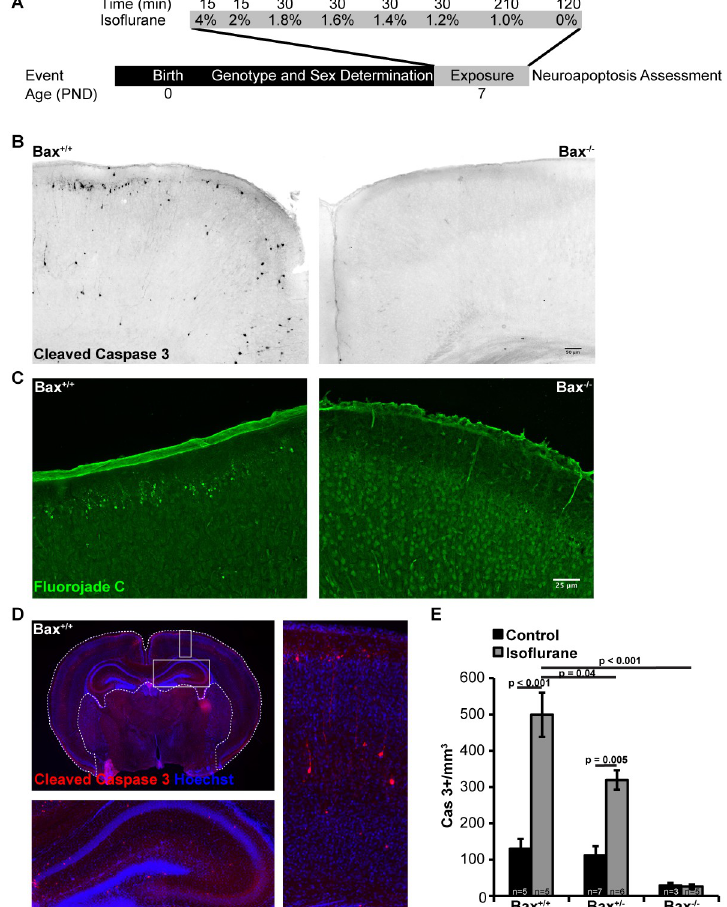
Fig 1. Neuron death occurs in neonatal animals exposed to isoflurane. A) diagram of the experimental isoflurane exposure paradigm. On PND 7 mice were exposed to isoflurane which was partially titrated to a level of 1 MAC over the duration of the exposure. The time (in minutes) mice were exposed to each concentration of isoflurane is shown along the top. B) Coronal sections approximate to Paxinos plate P6 #30 from Bax +/+ and Bax -/- animals exposed to isoflurane and probed for cleaved caspase 3. C) Coronal sections similar to (B) but stained with Fluorojade C reveals dye accumulation in many neurons in the exposed Bax +/+ animals and few in Bax -/- animals. D) Representative brain section labeled for cleaved caspase 3 with the region of interest (dashed line) wherein the number of cleaved caspase 3 positive neuron profiles was counted. Insets showing higher magnification of the hippocampus and cortex are outlined with a solid line. E) Results of the quantification of cleaved caspase 3 neurons profiled within the region of interest indicated in (D). treatment, cleaved caspase-3 containing neurons were readily detectable throughout the brain. Consistent with previous descriptions, the distribution of cleaved caspase-3 neurons was higher in the superficial cortex and in layer V, where morphological features of pyramidal neu- rons were apparent [9, 28]. Assessment of cell death in wild-type animals using an unbiased marker of dead and degenerating neurons, FluoroJade C, revealed a pattern of neuron death similar to that seen with cleaved caspase-3 (Fig 1C). This suggests that the majority of dying neurons were doing so via apoptosis. The number of apoptotic cells was quantified by count- ing the number of cleaved caspase-3 positive cells with neuronal morphology within a region of interest that included the cortex and hippocampus (Fig 1D). This analysis revealed that iso- flurane exposure results in a 5-fold increase in cleaved caspase-3 positive neurons compared to control treated wild-type animals (Fig 1E).